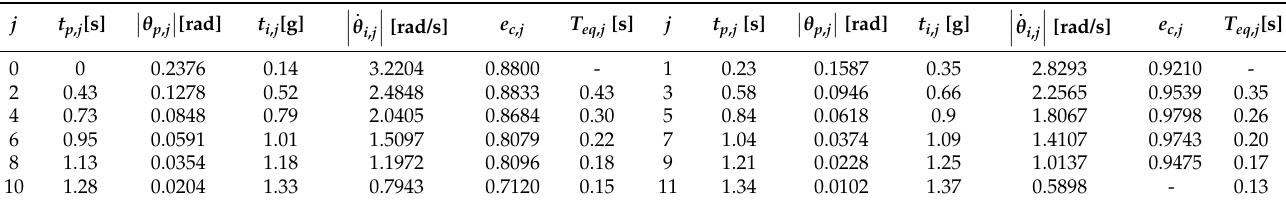
Table 11. Summary of the results of the free oscillation test block type